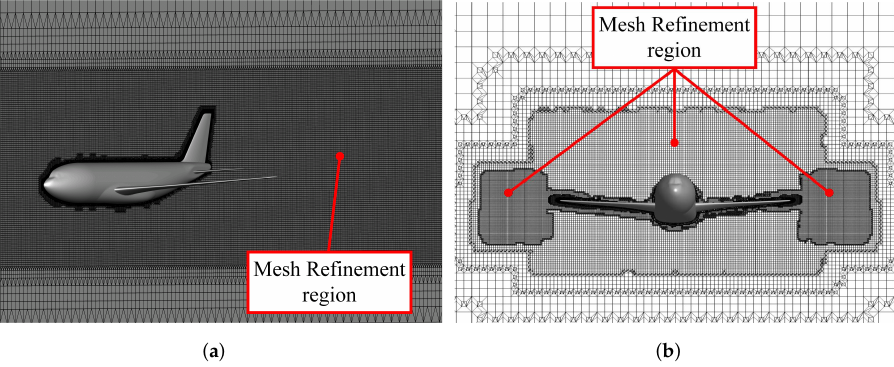
Figure 16. Computational grid for the numerical simulation of the wing–body. ( a ) mesh of numerical simulation (spanwise cross-section); ( b ) mesh of numerical simulation (steamwise